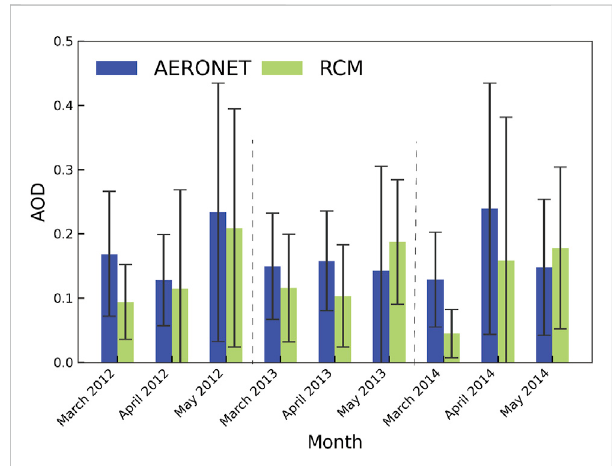
FIGURE 2 Comparison of monthly mean AOD between